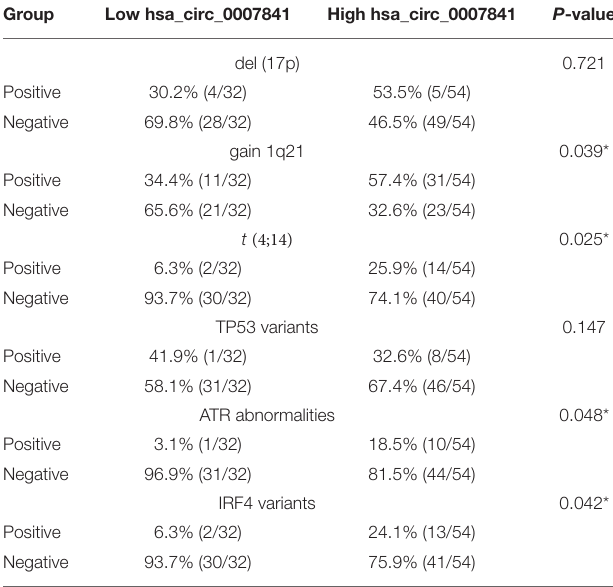
FIGURE 3 | The role of hsa_circ_0007841. (A) ROC curve for hsa_circ_0007841. (B) Kaplan-Meier survival curve for low and high expression of hsa_circ_0007841 in MM patients. MM, multiple myeloma; ROC curve, receiver operating characteristic curve. TABLE 3 | Cytogenetic aberration status distribution between low/high hsa_circ_0007841 expression groups of MM